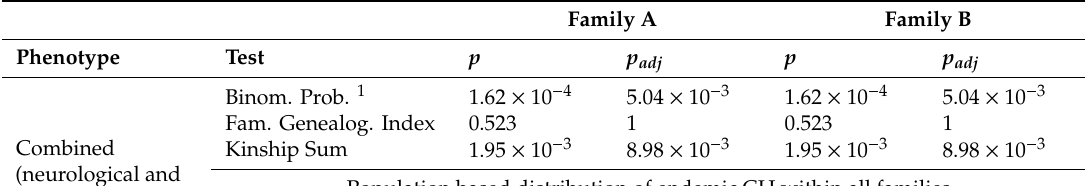
Table 4. Statistical analysis of the distribution of endemic CH familial aggregation within two families and within the whole